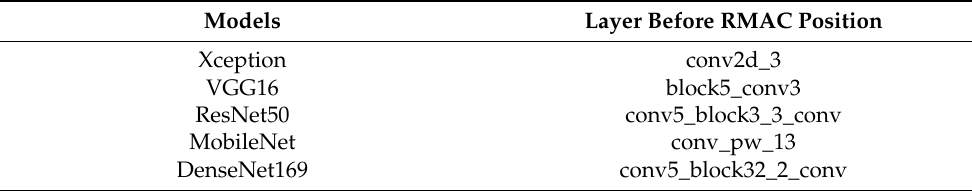
Table 3. Previous layer of the RMAC position based on models.